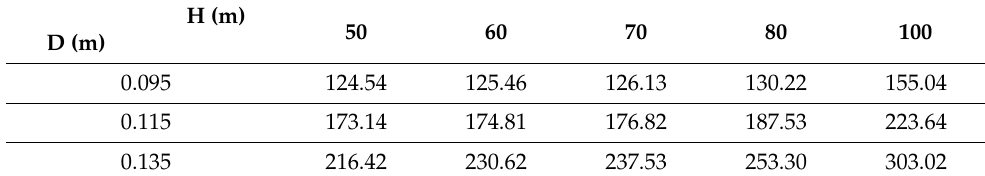
Figure 12. Platform pitch motion ( left ) and offset ( right ) for the different water depths with wind, wave and current at 0°. Table 10. Value of cost index of each mooring line (unit: ton).